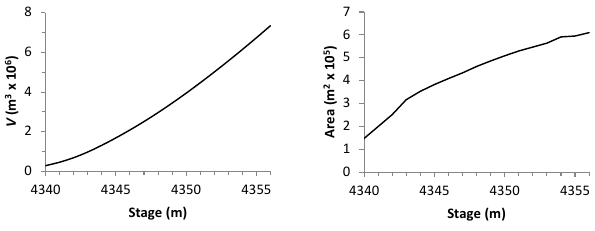
Figure 2. Bathymetric data describing (a) volume–stage and (b) area–stage relationships, extracted from a fine-resolution, structure-from-motion-derived digital terrain model of the Dig Tsho moraine-dammed lake basin (Westoby et al.,